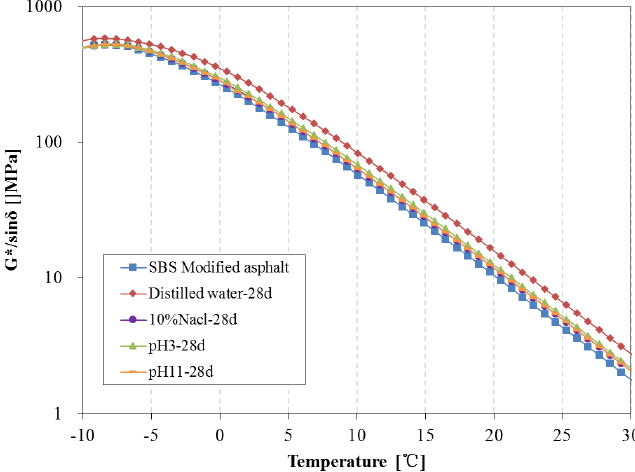
Figure 17. Rutting parameter of SBS modified asphalt before and after 28 days immersion.